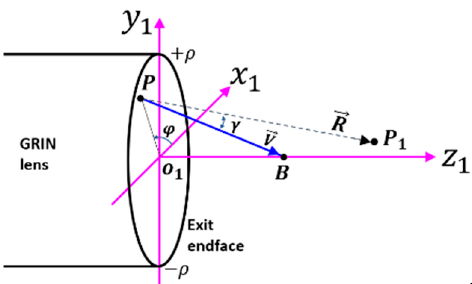
Figure 5. Coordinate system for calculating the diffraction pattern. Definitions of 𝑃 and 𝐵 are the same as those in Figure 3.